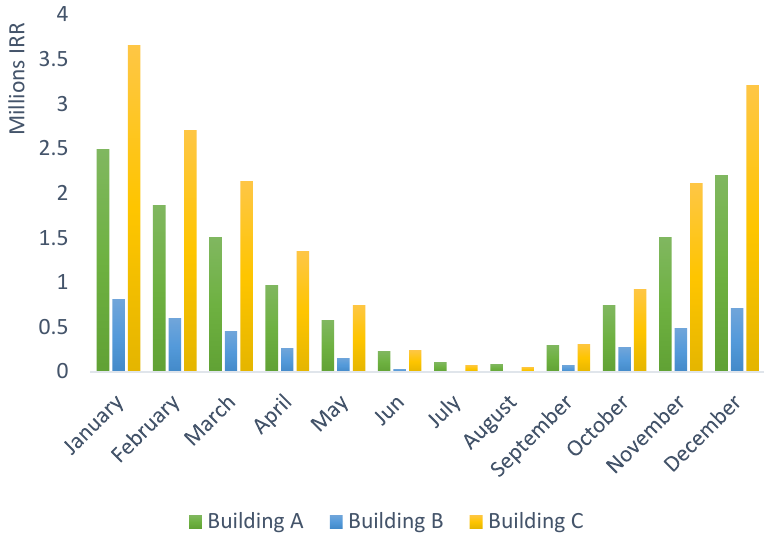
Figure 14. Comparison of the average monthly natural gas cost for consumers.